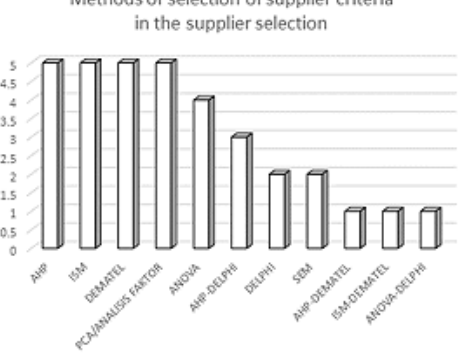
Figure 3. Methods of selection of supplier